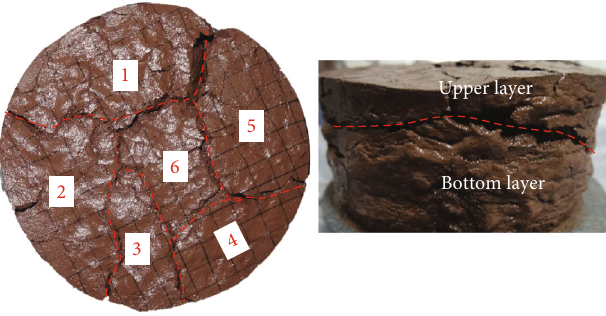
Figure 25: Measuring water content of 2# sample. Table 5: Water content in di ff erent areas (unit: %).